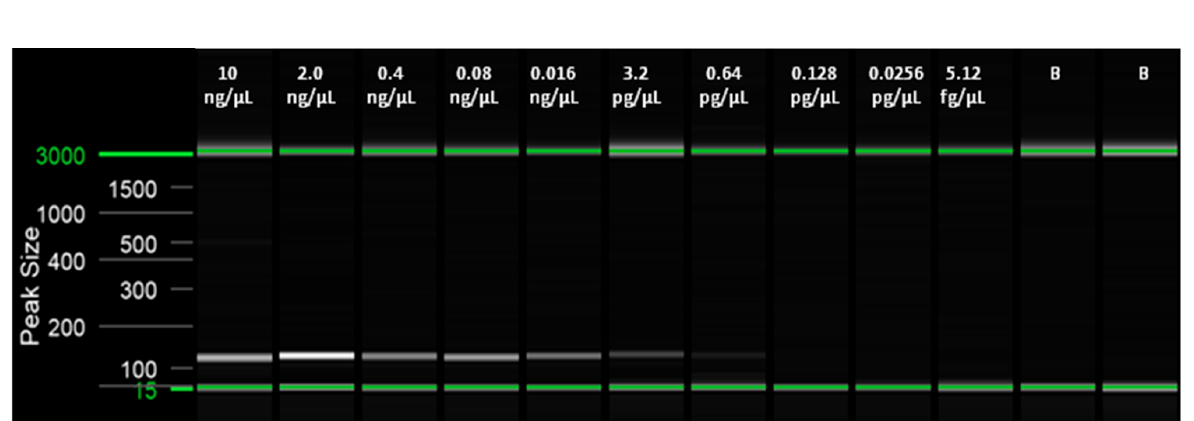
Figure 2. Capillary electrophoresis using the QIAxcel Capillary Electrophoresis System (QIAgen, Valencia, CA, USA) of end point PCR carried out with the primers 14F/125R on serial 1:5 dilutions of WTB adult DNA.